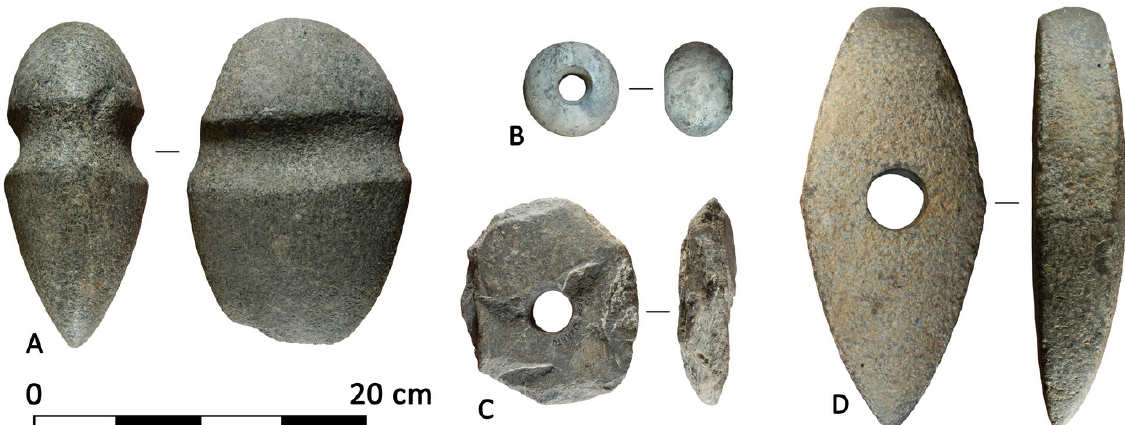
Figure 7. Ground stone percussors found in Sardinia and preserved at the Museo Archeologico Nazionale in Cagliari: grooved hammer-axe (A); maces with central hole (B-C); “flatiron” shaped axe (D). (Photo by F.